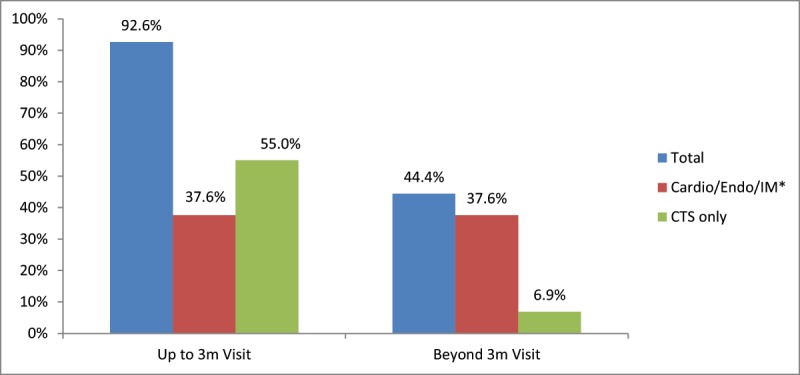
Percentage of CABG patients who completed a clinic visit at the different time intervals (up to 3 months and beyond 3 months) following surgery based on the specialty of the providers.* Patients seen by a medical specialty physician (cardiology, endocrinology and/or internal medicine) might also have been seen by cardiac surgery (CTS).